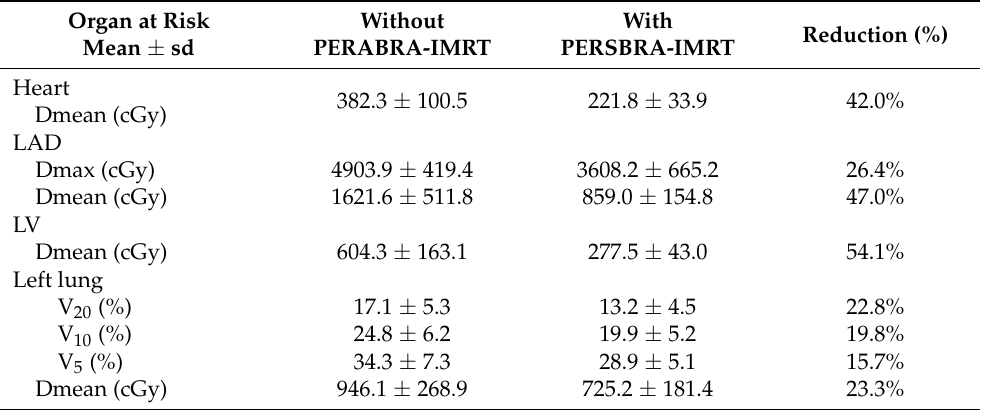
Table 3. Dosimetric comparison of organs at risk between patients with and without PERSBRA in IMRT (mean ± SD, n = 24). Organ at Risk Without Mean ± sd PERABRA-IMRT